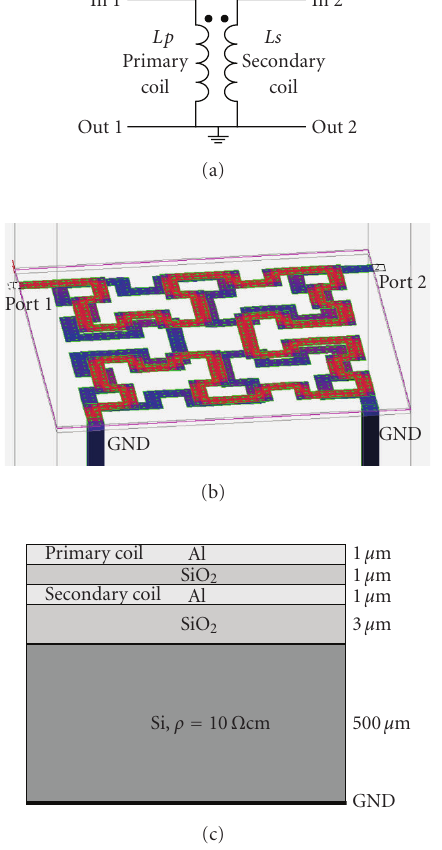
Figure 4: A stacked fractal transformer: (a) schematic symbol, (b) 3D model, and (c) the cross-section.